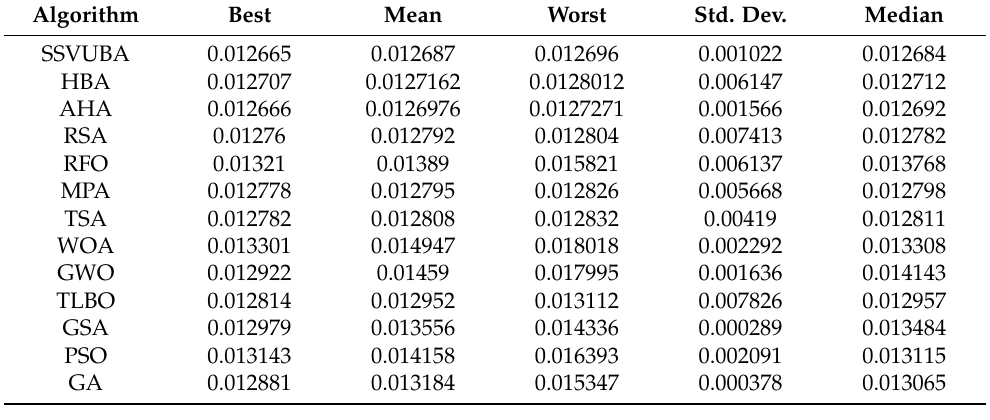
Figure 14. Schematic of the tension/compression spring design.